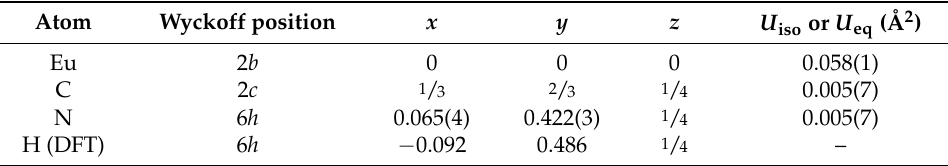
Figure 8. Rietveld refinement of EuC(NH) 3 ( a ), showing several unidentified reflections. The crystal structure of EuC(NH) 3 ( b ). Table 4. Atomic positions and displacement parameters of EuC(NH) 3 in space group P 6 3 / m . Hydrogen position determined from DFT.